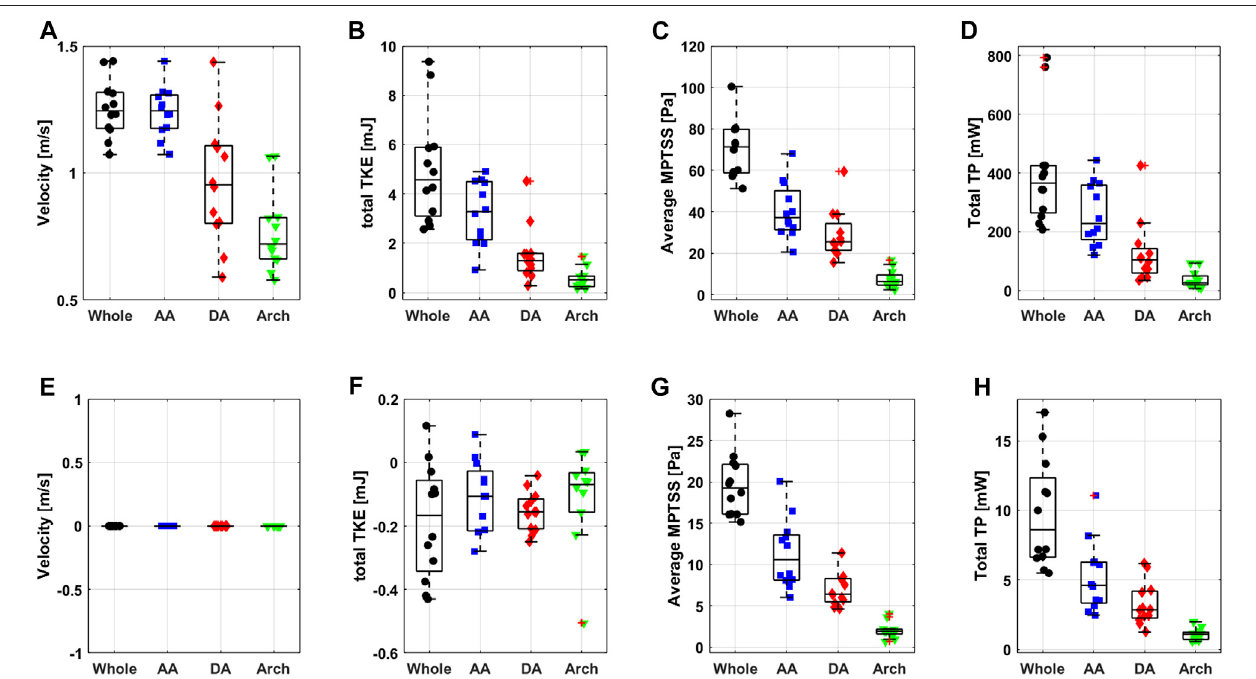
FIGURE8| Boxplotofpeaksystolic (A) velocity, (B) totalTKE, (C) averageMPTSS, (D) totalTPanddiastolic (E) velocity, (F) totalTKE, (G) averageMPTSSand (H) total TP.